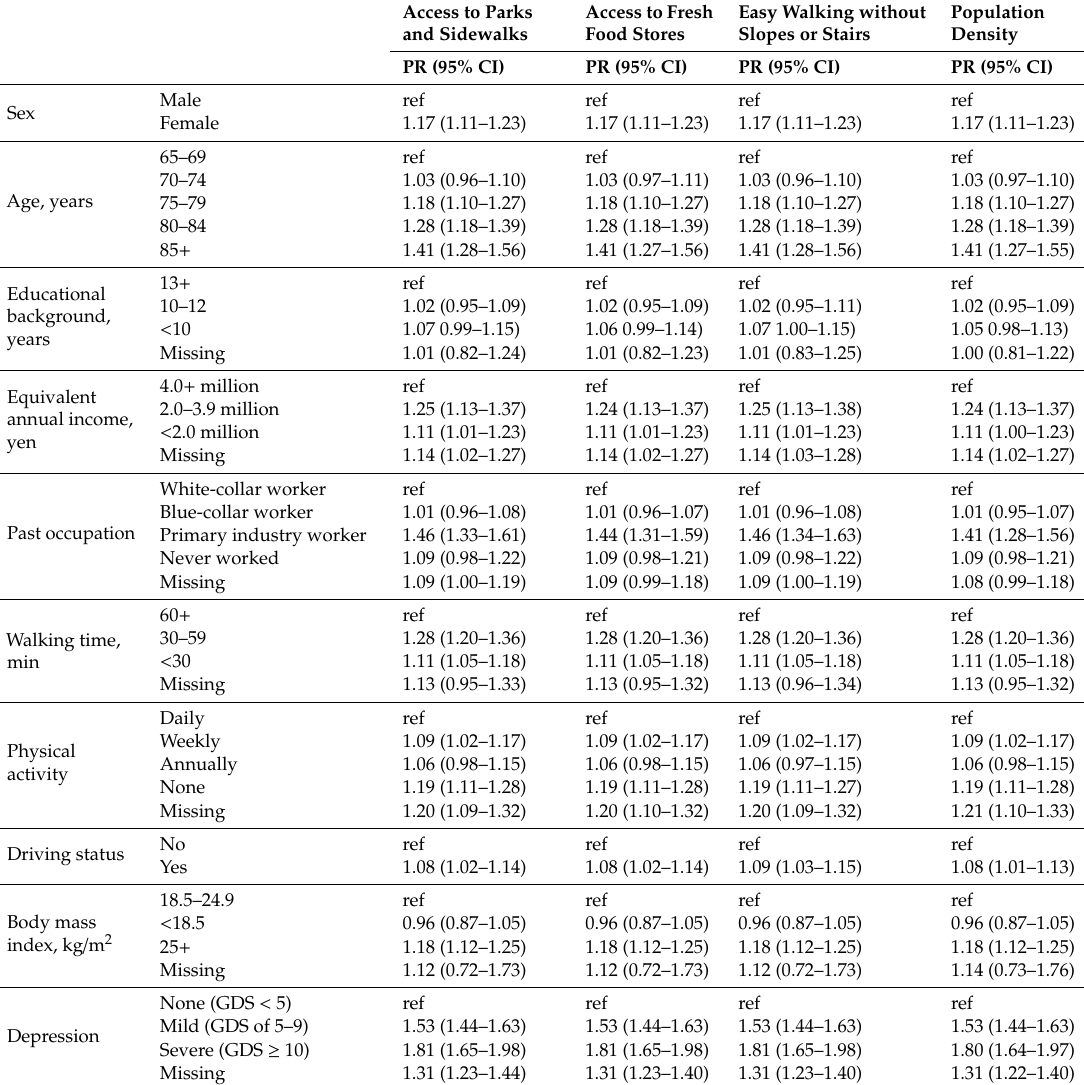
Table A2. Association between covariates and low back pain by multilevel Poisson regression analysis ( n =